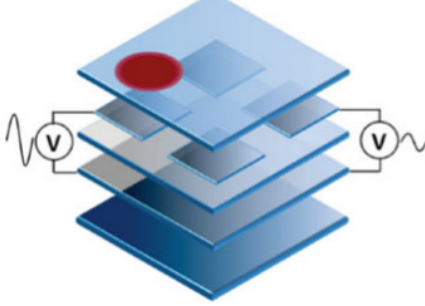
Figure 9. The propagated stress is related to the detection accuracy [42].